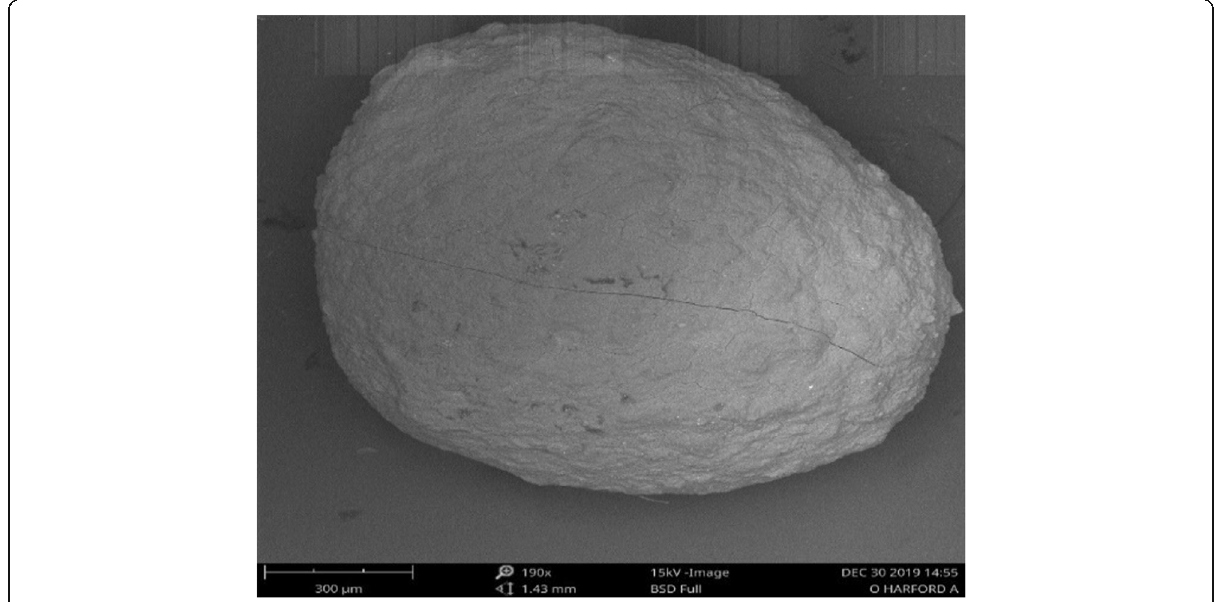
Fig. 5 SEM micrograph of metformin-loaded